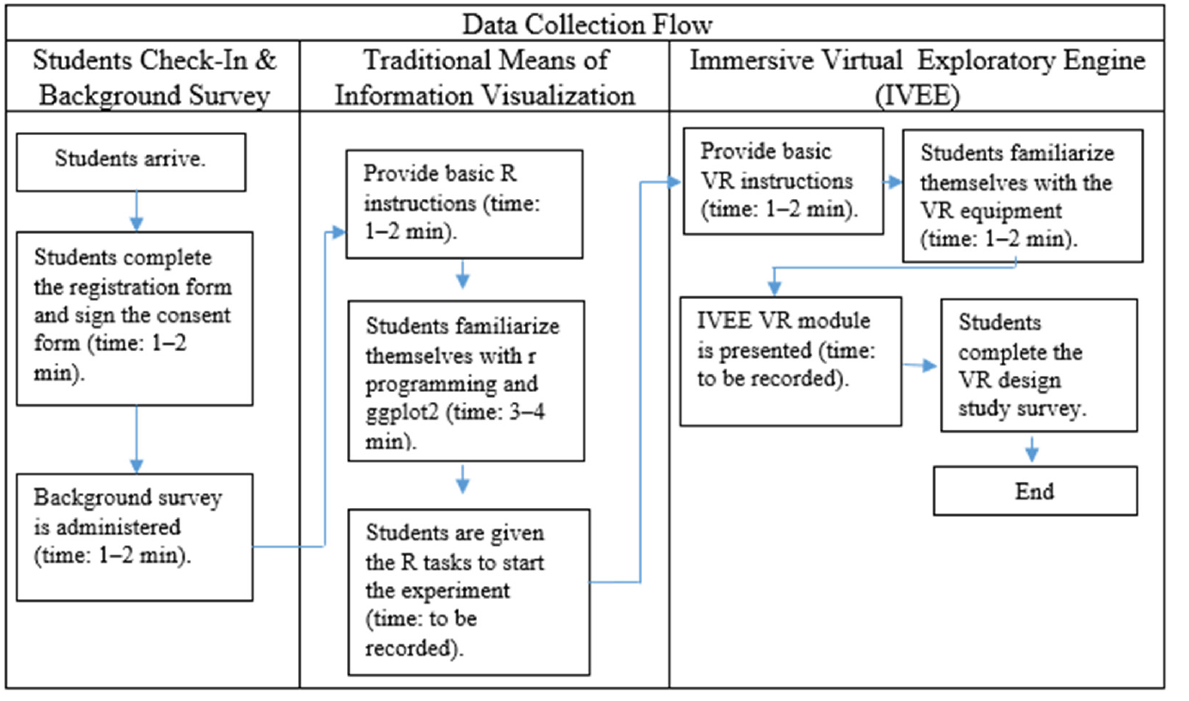
Figure 13. Data Collection process .